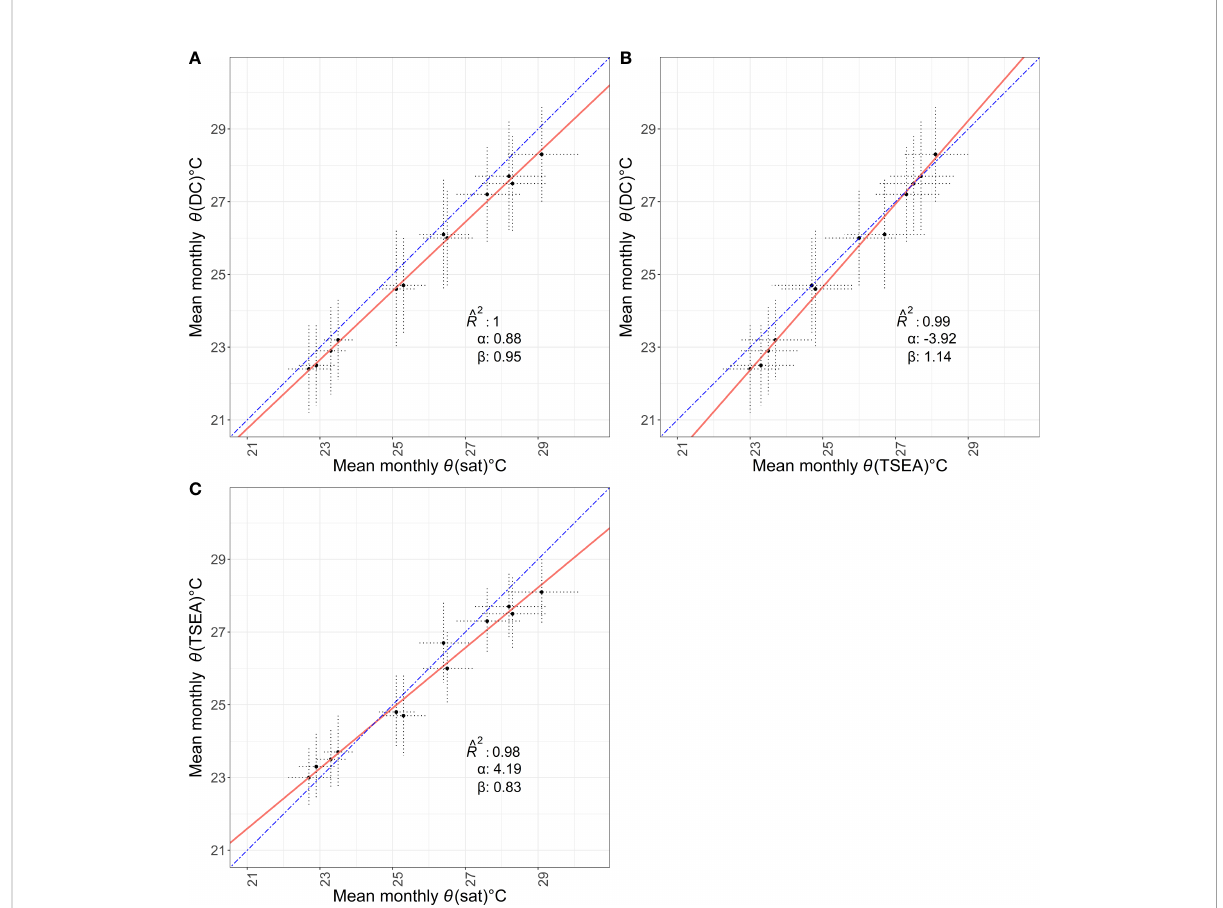
FIGURE 4 Solid line shows York regression on mean monthly temperature for (A) q (sat) - q (DC), (B) q (TSEA) - q (DC) and (C) q (sat) - q (TSEA), showing intercept a , slope b and R ̂ 2 . Dashed line is 1:1. Error bars are standard deviation for a given month/dataset, across all